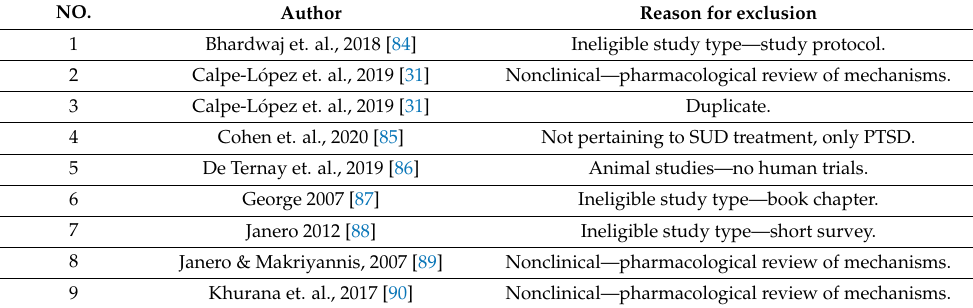
Figure A1. Search Figure A1. Search strategy.